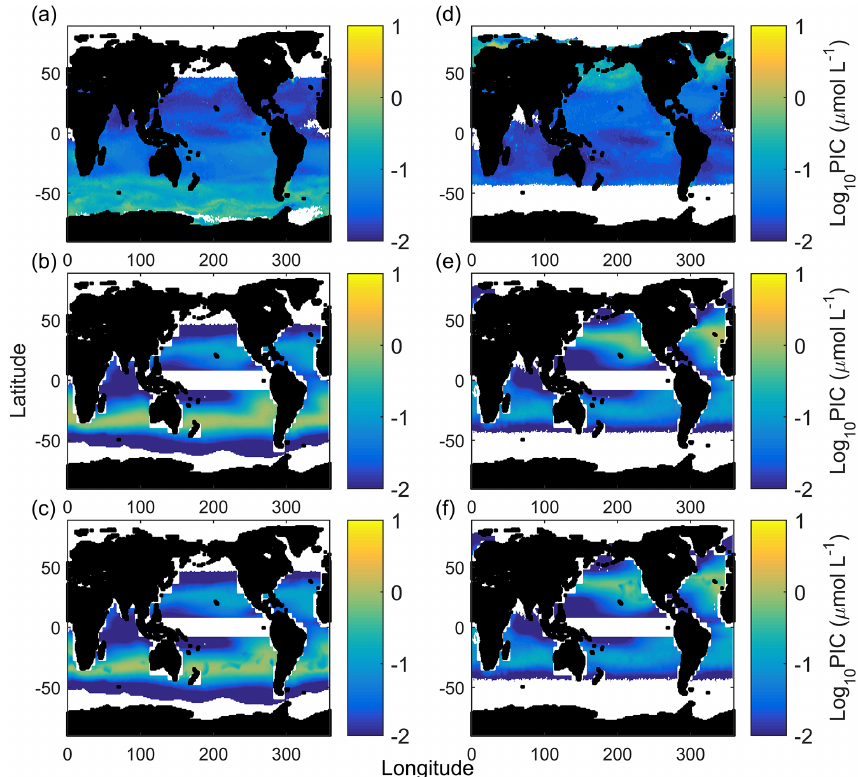
Figure 7. Austral summer/boreal winter (a) and austral winter/boreal summer (d) satellite-measured particulate inorganic carbon. Aus- tral summer/boreal winter (b) and austral winter/boreal summer (d) E. huxleyi -based CCPP estimates accounting for carbonate chemistry (substrate and hydrogen ion concentrations), light intensity and temperature. Note the strong bands of CCPP at the midlatitudes. Austral summer/boreal winter (c) and austral winter/boreal summer (f) CCPP estimates accounting for carbonate chemistry (substrate and hydrogen ion concentrations), light intensity and temperature and nitrate concentrations (nutrient